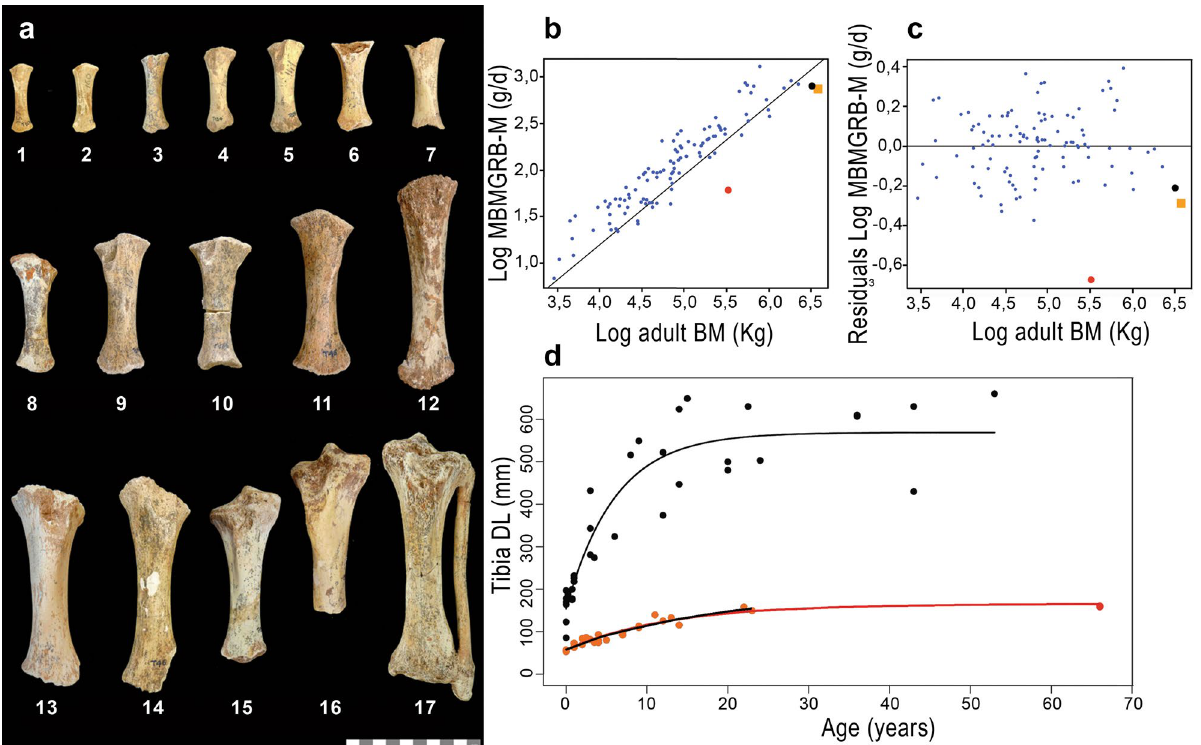
Figure 1. P. falconeri GR. ( a ) sample of the aged tibiae: 1,2: neonates (CAT-106; CAT-108); 3: one year (ELEPH1-T); 4: two years (CAT-124); 5: 3,5 years (CAT-128); 6,7,8: 4 years (CAT-132, Cat 133, ELEPH2-T); 9,10: 7 years (CAT 139, Cat 140); 11,12: 9 years (CAT-45, 142); 13: 12 years (ELEPH3-T); 14: 13 years (CAT- 46); 15: 14 years (CAT-179); 16: 18 years (T-181);17: 23 years (Roma 6) (Graphic scale 10 cm). ( b ) Scaling of mean body mass GR from birth to maturity (MBMGR, expressed in grams/day) in respect to adult body mass, in log10, using phylogenetic generalized least square regressions (PGLS), in a large sample (n = 106) of species of ungulates (see Supplementary material 8 for results of PGLS). Blue dots: ungulates; red dots: P. falconeri (body mass from tibia LTC; Supplementary material 2; Supplementary Tables 2, 3), black dot: Elephas maximus ; orange square: L. africana ; data from PanTheria 33 . ( c ) distribution of residuals of the PGLS log10MBMGRB-M (adult-neonatal body mass, gr/age from birth in days) (y) regressed against log10 adult body mass (x). Extant elephants (orange square: L. africana , black dot: E. maximus ) are within the lower limit of adult body mass- neonatal body mass GR in ungulates; P. falconeri (red dot) corresponds to the body mass estimation of tibia LTC (Supplementary material 2). ( d ) Von Bertalanffy growth curves of diaphyseal lengths of the tibiae (TDL) of L. africana (black dots and black curve) and P. falconeri (red dots; black and red curves). P. falconeri growth model 1 (short black curve) is based on ontogenetic data of specimens directly aged by skeletochronology (red dots). The long red curve corresponds to model 2 and is based on the inferred minimal longevity (Table 1; “Materials and methods”) and the maximal value of